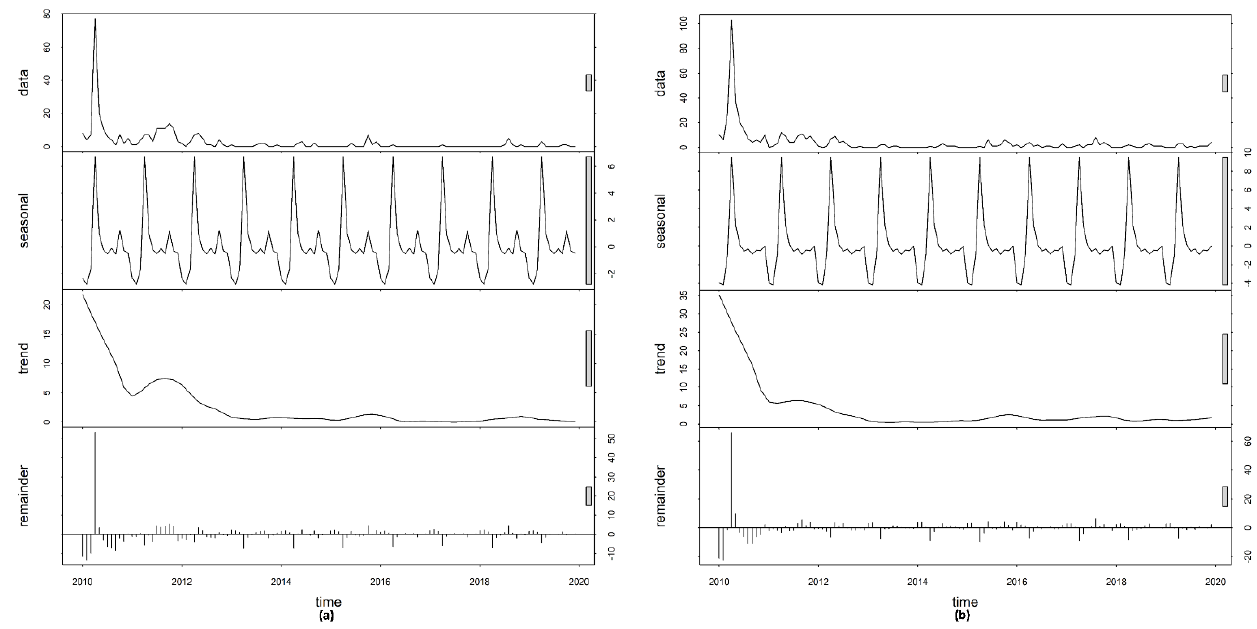
Figure 2. Decomposed ( a ) Plasmodium falciparum and ( b ) Plasmodium vivax cases of Bhutan, 2010 – 2019.